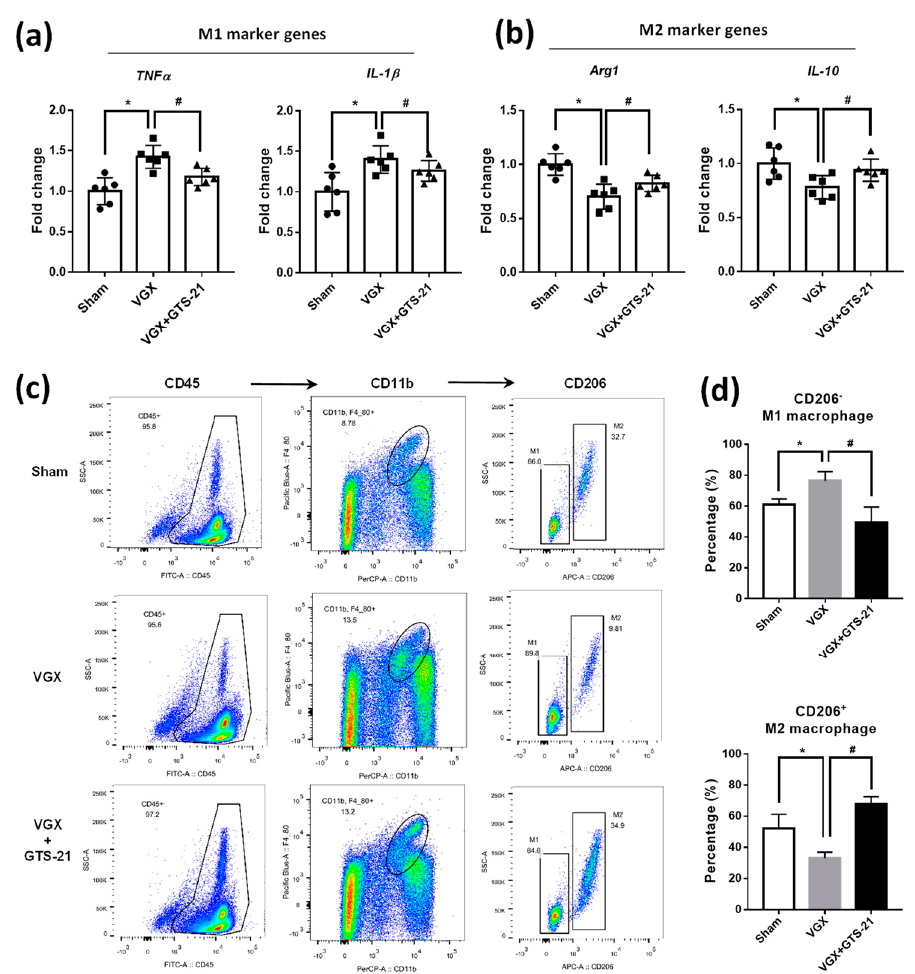
Figure 2. Effects of CAP activity on the quantity of M1 and M2 macrophages. ( a , b ) The mRNA expression analysis of M1 pro-inflammatory genes, i.e., TNF α and IL-1 β ( a ), and M2 pro-reparative genes, i.e., Arg1 and IL-10 ( b ), in plaques of the thoracic aorta. Data are presented as mean ± SD ( n = 6 mice), * p < 0.05 as compared to sham; # p < 0.05 as compared to VGX; ns indicates not significant. ( c ) Representative images showing flow cytometry analysis of M1 and M2 macrophage in the blood of the three experimental mice. The CD45 + CD11b + CD206 − cells were classified as M1 macrophage, while the CD45 + CD11b + CD206 + cells were identified as M2 macrophage. ( d ) Relative quantification of the change in the number of M1 (up panel) and M2 (down panel) macrophages. Data are presented as mean ± SD ( n = 3 mice). * p < 0.05 as compared to sham; # p < 0.05 as compared to VGX; ns indicates not significant.